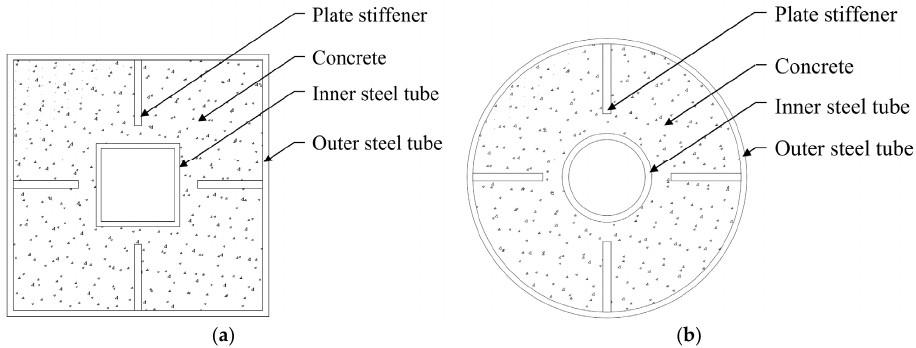
Figure 3. The cross-section of the CFDST columns . ( a ) Typical square CFDST with plate stiffeners. ( b ) Typical circular CFDST with plate stiffeners.